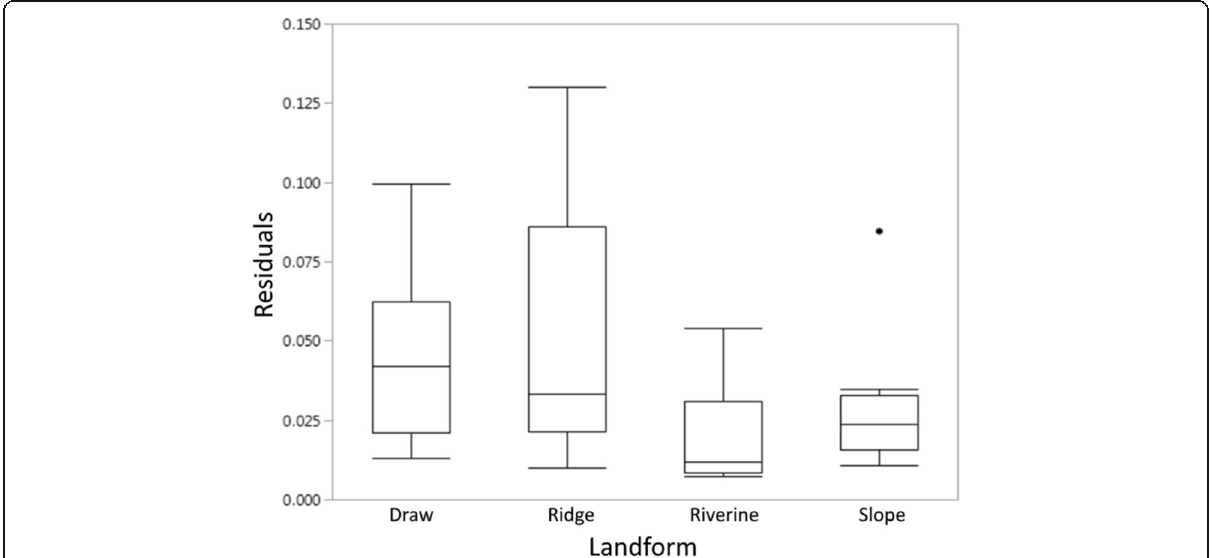
Fig. 3 Raw (non-normalized) Procrustes residuals by landform type from a Procrustes rotation of NMDS ordinations for each year shown in Fig.